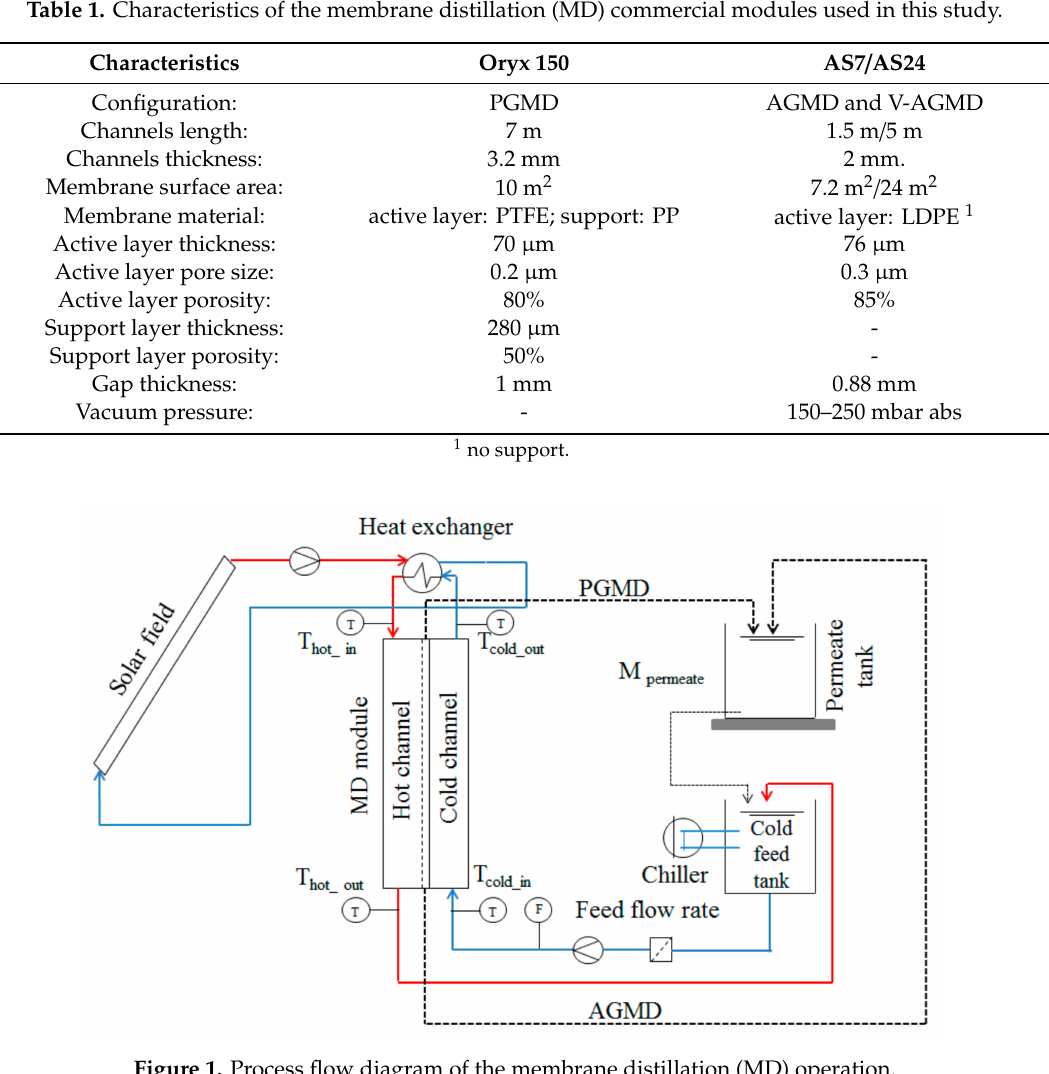
Figure 1. Process flow diagram of the membrane distillation (MD)